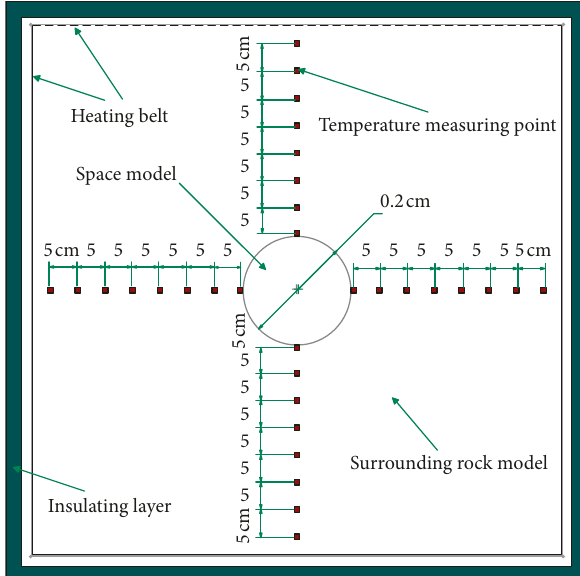
Figure 3: Layout of measuring points in the surrounding rock